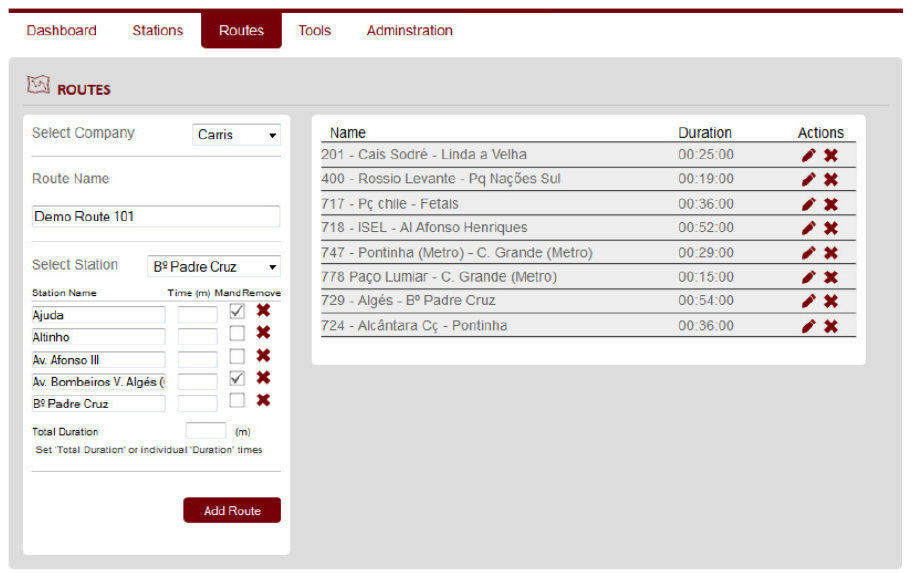
Figure 6. Monitoring tool: adding stations.